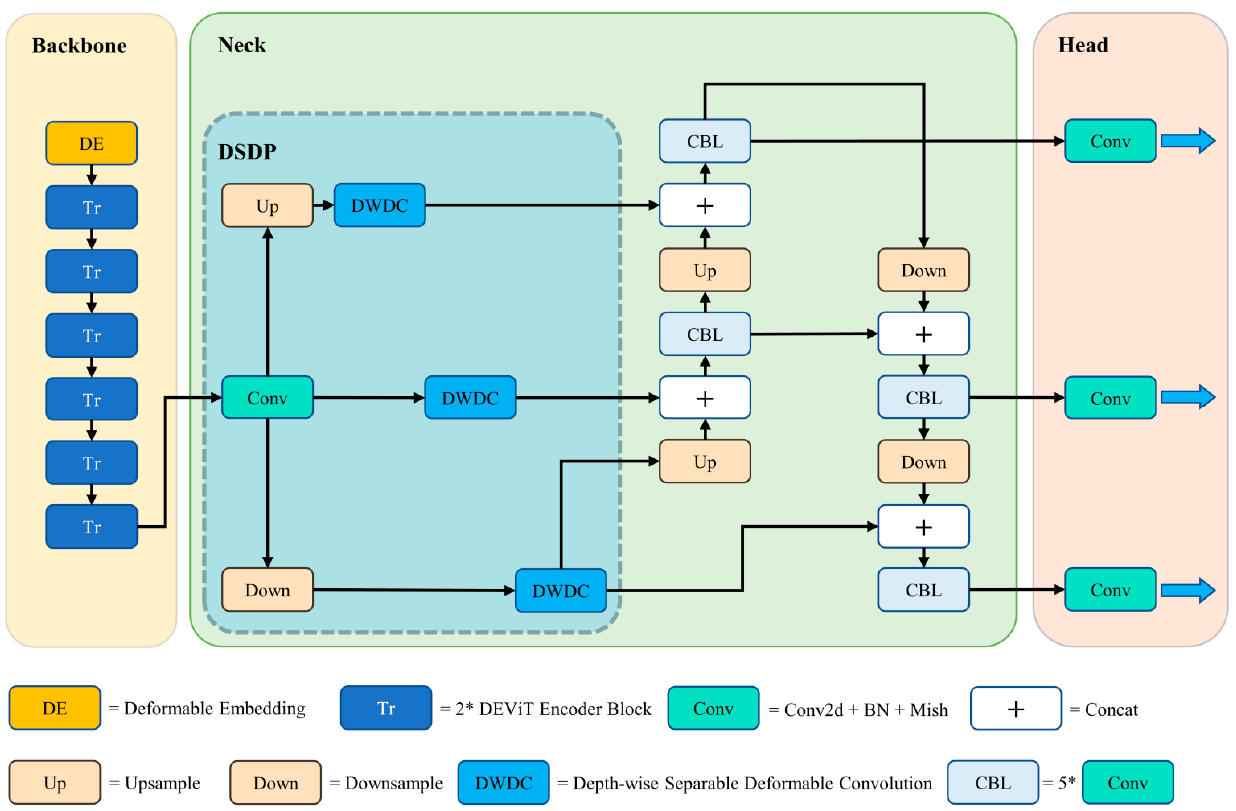
Figure 1. An overview of DET-YOLO. We use DEViT as the backbone, as opposed to CSPDarknet53 in the original implementation. In addition, the DSDP module is utilized in place of skip connections and SPP in order to obtain multiscale feature maps.